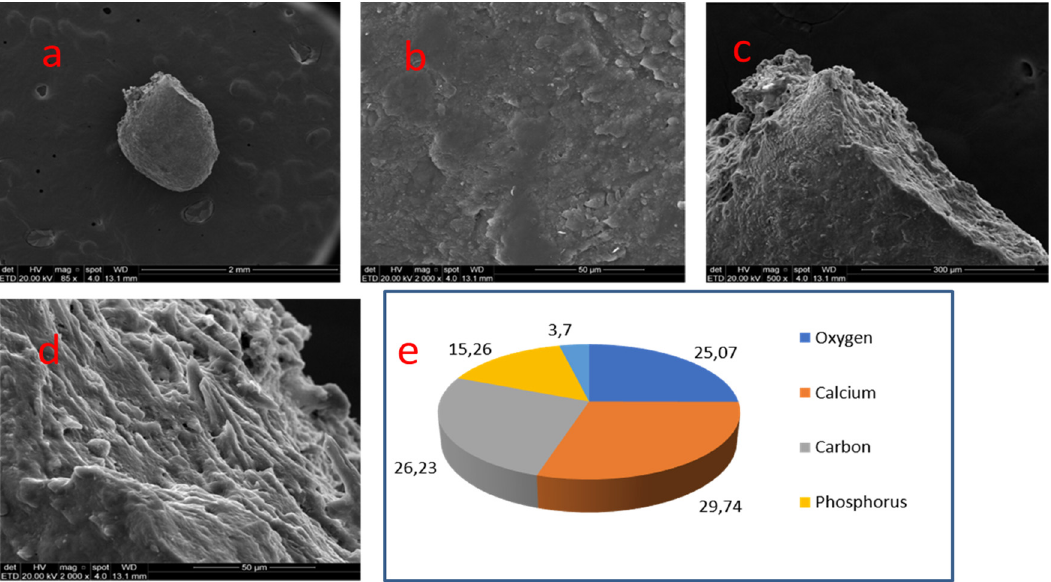
Figure 6. Sample 04: ( a ) An ovoid nodule with a smooth surface and compact presentation (SEM, 85 × ); ( a , b ) closer view of the smooth and compact surface (SEM, 2000 × ); ( c ) prominence with porous surface (SEM, 500 × ); ( d ) porous area with chip-like projections (SEM, 2000 × ); ( e ) Results of chemical analysis of the sample with X-ray dispersive energy spectroscopy (EDX).